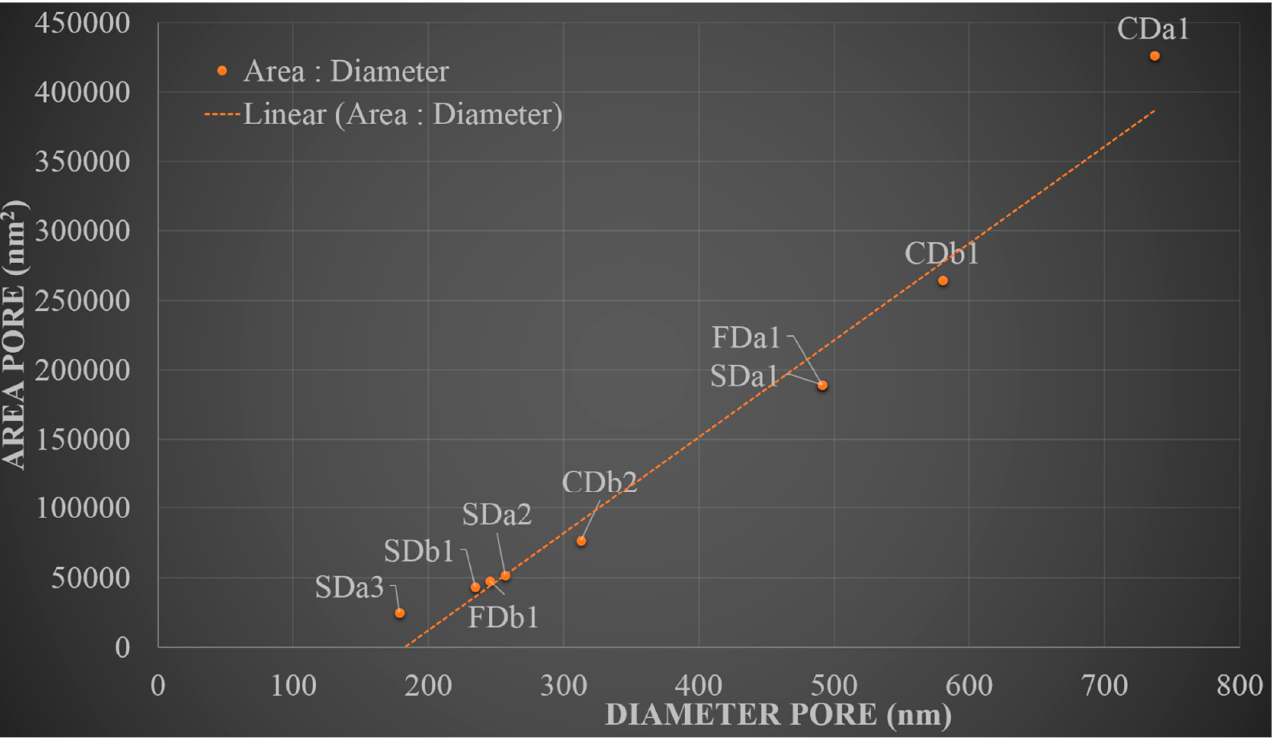
Figure 5. Pore areas and diameters from various magnifications in the top, side and cross ‐ section of biomaterials.